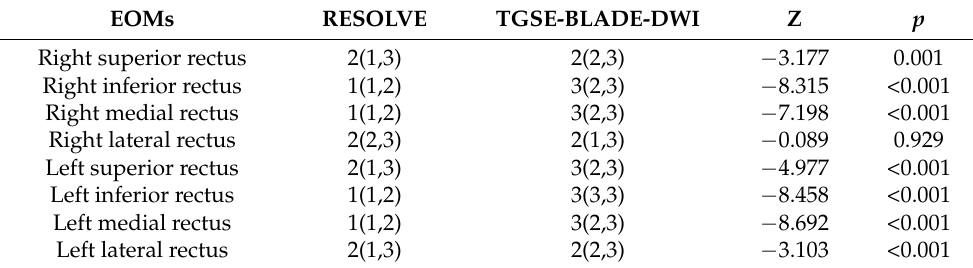
Left lateral rectus 2(2,3) − 3.103 <0.001 EOMs, extraocular muscles; TAO, thyroid-associated ophthalmopathy; RESOLVE, readout-segmented echo-planar imaging; TGSE-BLADE-DWI, turbo gradient and spin-echo BLADE diffusion-weighted imaging; M (Q1, Q3) represented the median, first, and third quartiles.